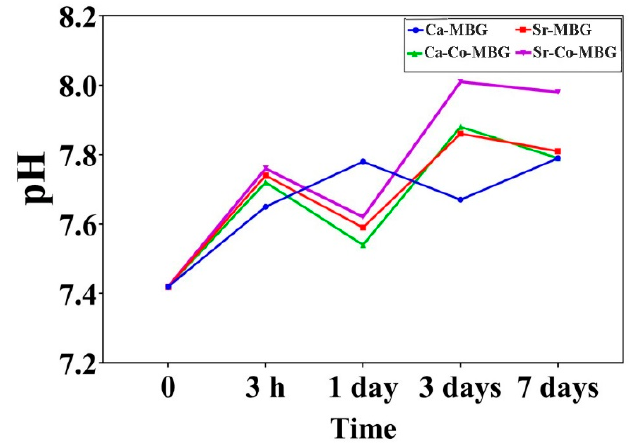
Figure 8. Results of pH measurements in SBF. Table 7. Results of ICP measurements in SBF (ion leaching test).